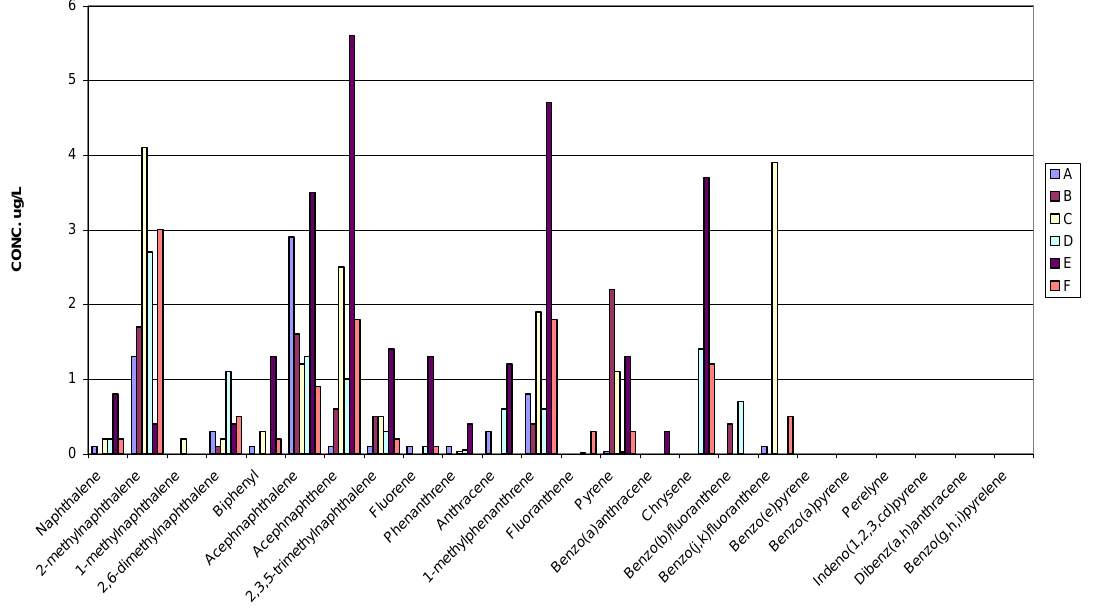
FIGURE 2. Types of average PAHs FIGURE 2. The average PAHs found in the coastal